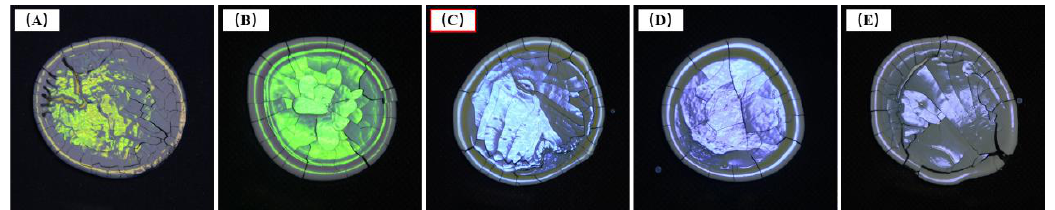
Figure 4. Photos of dried test samples of PSt microspheres synthesized with different amounts of SDBS added: ( A ) 125 mg; ( B ) 150 mg; ( C ) 175 mg; ( D ) 200 mg; ( E ) 225